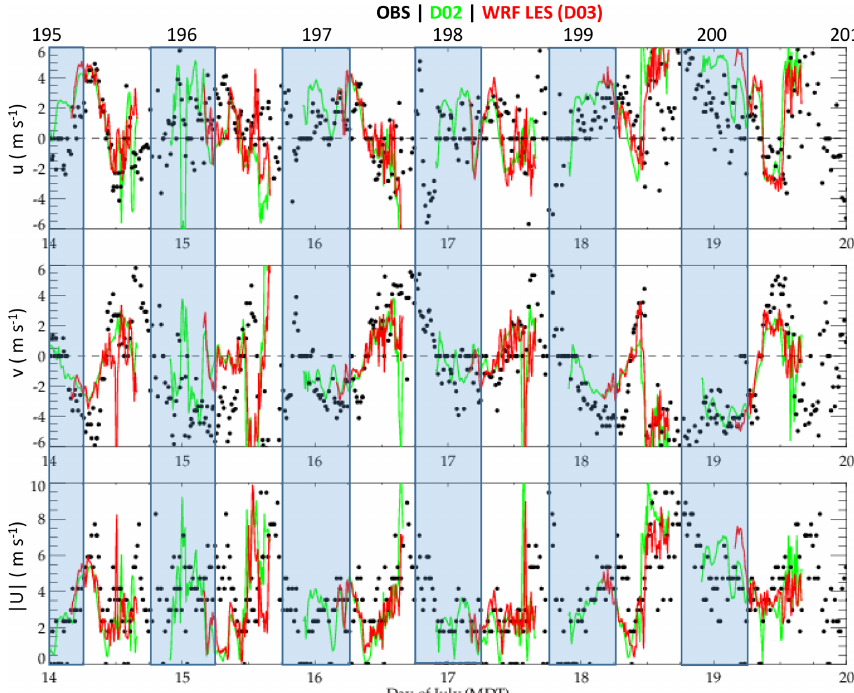
Figure 3. Comparison of predicted u wind component, v wind component and wind speed at 10ma.g.l. obtained from WRF D02 and WRF LES forced with 04:00UTC HRRR with observations (OBS) obtained from an AWOS surface meteorological station at Saguache Municipal Airport located at the base of Saguache Canyon. WRF-D02 data are instantaneous values while WRF LES data are 10min averages. AWOS data from SAG are plotted when available (roughly every 15min). Nighttime conditions are indicated by the blue regions (approximately 18:00 to 06:00MDT). Day of year is indicated along the top. The location of the SAG AWOS station is marked with an “*” in Fig.